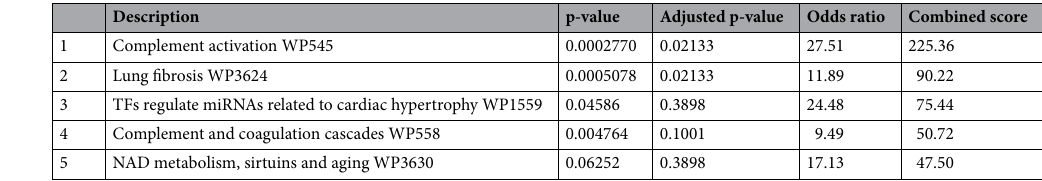
Table 2. Wikipathway down-regulated DEGs enrichment analysis.